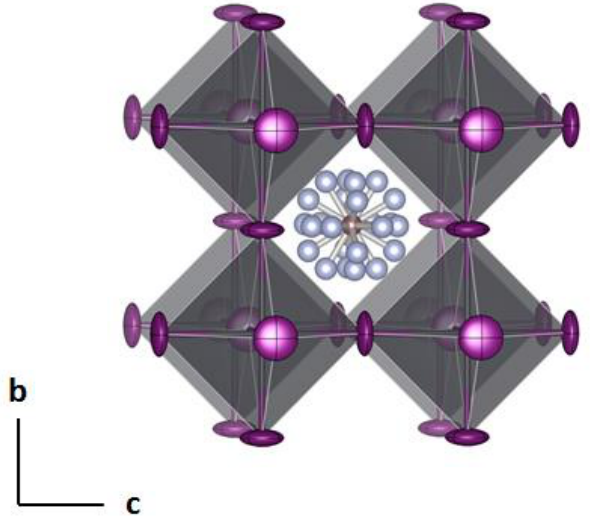
Figure 2. View of the cubic Pm -3 m MAPI O (synthesized in γ -butyrolactone, GBL, without additives) crystal structure down [100]. PbI 6 , grey octahedra; I, violet. The MA + (C: brown and N: blue) disorder is modelled over 24 equivalent positions inside the perovskite cage. Ellipsoids are shown with 50% probability.